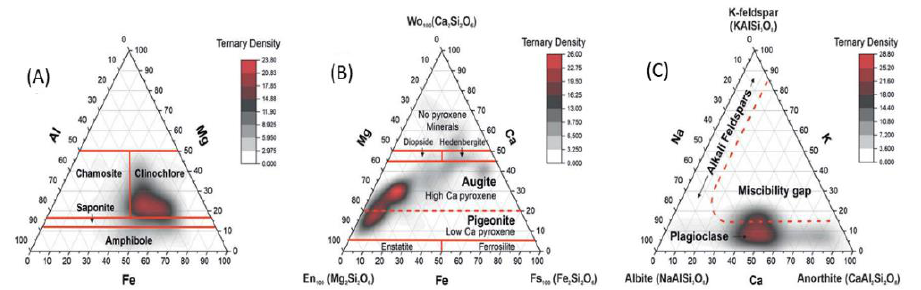
Figure 4. Ternary plots of the elements relevant ( A ) chlorite group; ( B ) magnesium augite and pigeonite; ( C ) the plagioclase feldspars in the inclusion material. (Reproduced with the permission from the journal J. Anal. At. Spctrom. [81]).